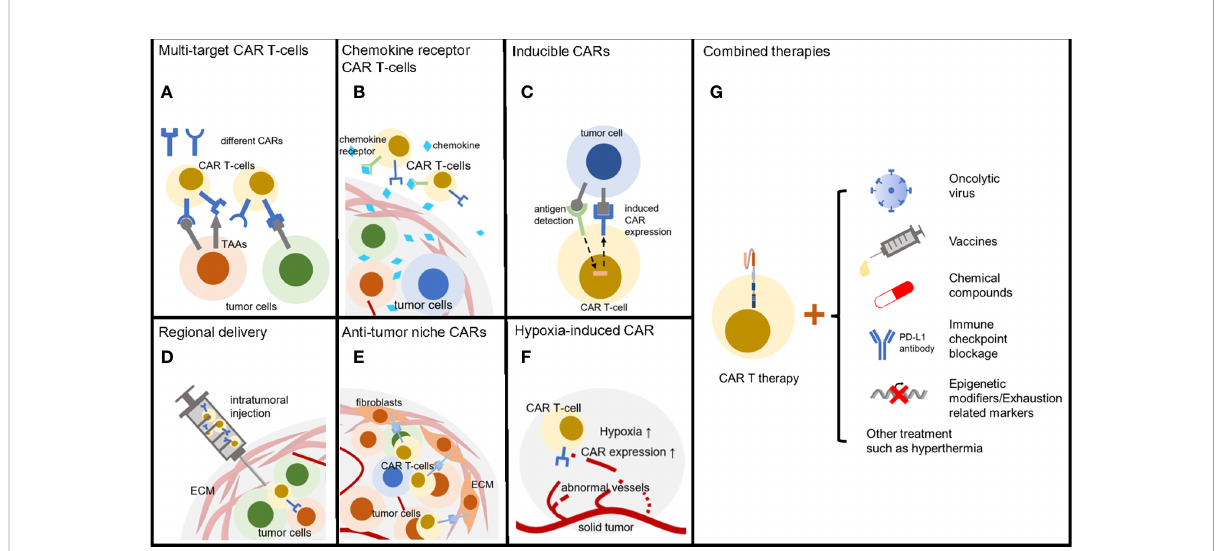
FIGURE 3 Methods to reverse CAR T therapy resistance. (A) T-cells armored with multi-speci fi c CARs can broadly target heterogeneous tumor cells. (B) CAR T-cells with chemokine receptor are able to ef fi ciently in fi ltrate solid tumors. (C) Inducible CARs enable T-cells precisely kill tumors cell with low exhaustion and off-tumor cytotoxicity. (D) Regional delivery directly transfers the CAR T-cells into solid tumors. (E) CARs targeting tumor niche can be an alternative anti-cancer choice through destroying of microenvironment. (F) Hypoxia inducible CARs have low off-target effect due to the regional activation. (G) Combined therapies including oncolytic virus, tumor vaccines, chemical drugs, ICB and epigenetic modi fi ers enhanced CAR T-cell treatment ef fi